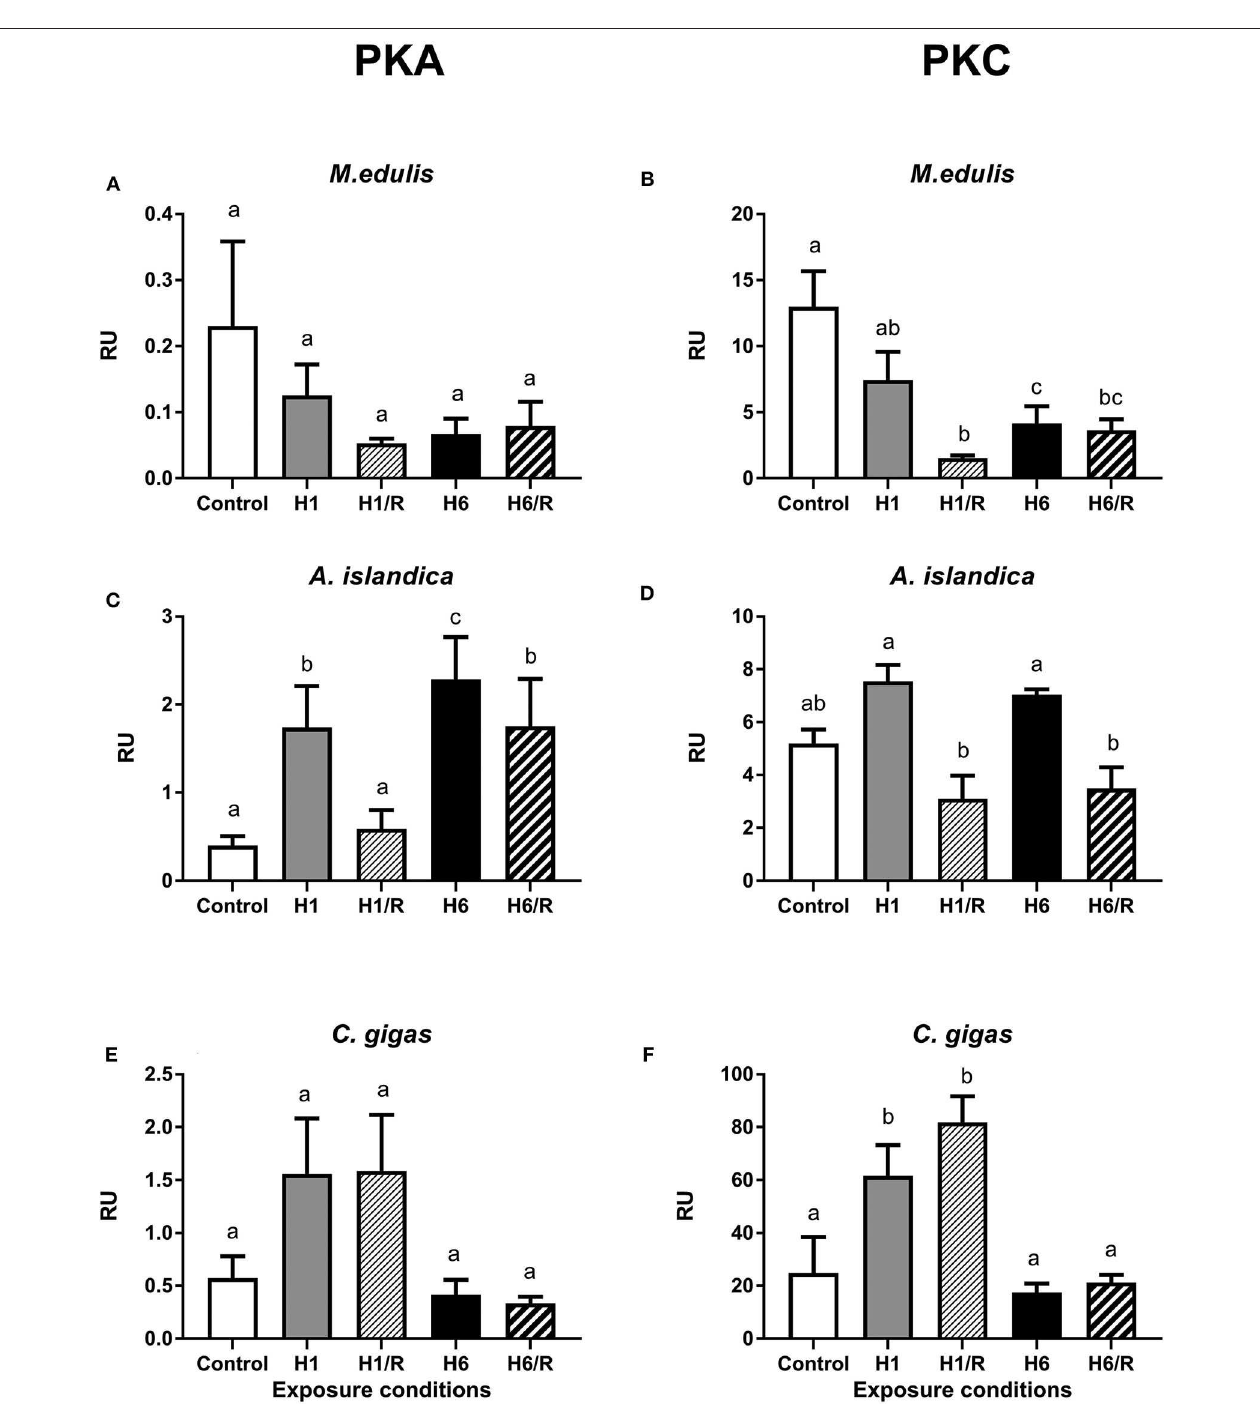
FIGURE 3 | Amount of PKA- and PKC-phosphorylated sites on the digestive gland proteins of three species of marine bivalves during the exposure to H/R stress. (A,B) The mussels M. edulis , (C,D) the quahogs A. islandica , and (E,F) the oysters C. gigas . Exposure conditions are control (normoxia), 1 day hypoxia (H1), 1h reoxygenation following 1 day of hypoxia (H1/R), 6 days of hypoxia (H6), and 1h reoxygenation following 6 days of hypoxia (H6/R). RU, relative units. Columns that do not share a letter represent significantly different values ( p < 0.05). The vertical bars represent S.E.M. N = 5. of the quahogs ( Supplementary Figure 4 ). The maximum animals exposed to 6 days of hypoxia or recovering after 1 day of hypoxia, which showed enhanced stimulation of the Complex I PKA-stimulated activity of the Complex I in A. islandica was activity by PKA ( Supplementary Figure 4 similar under most experimental conditions, except for the